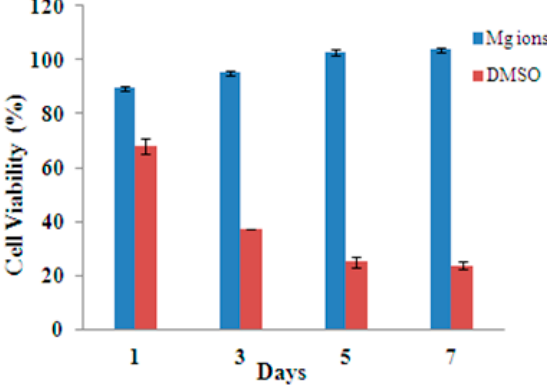
Figure 6. Effect of Mg ions (103.3 ppm) on the HUVECs examined by MTT assay after 1, 3, 5, and 7 days of exposure.